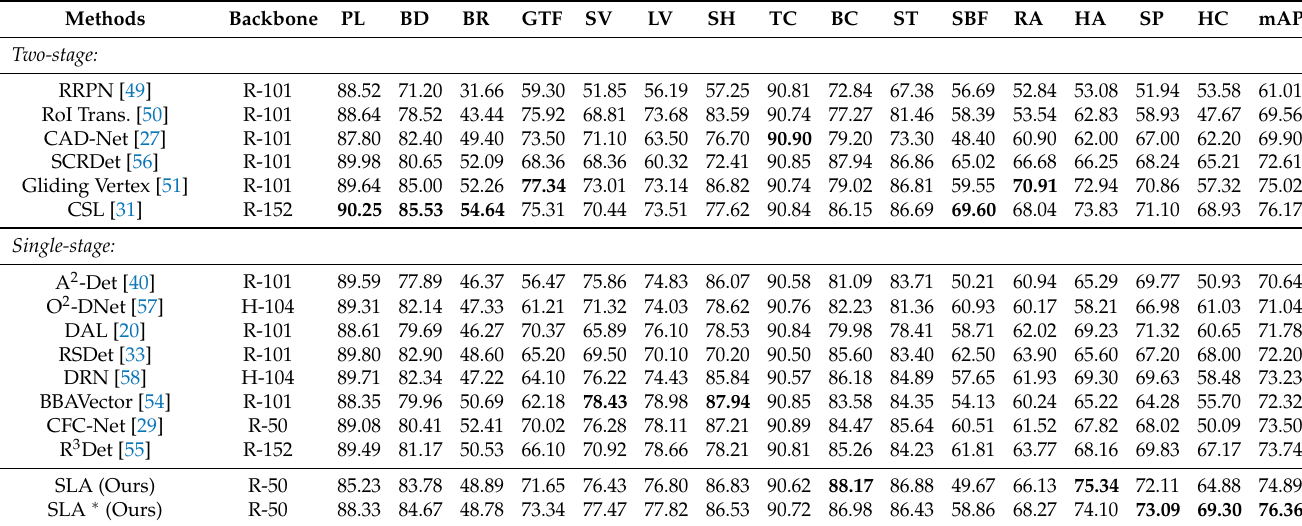
Table 8. Comparisons with other state of the art methods on DOTA dataset. * denotes using multi-scale testing.